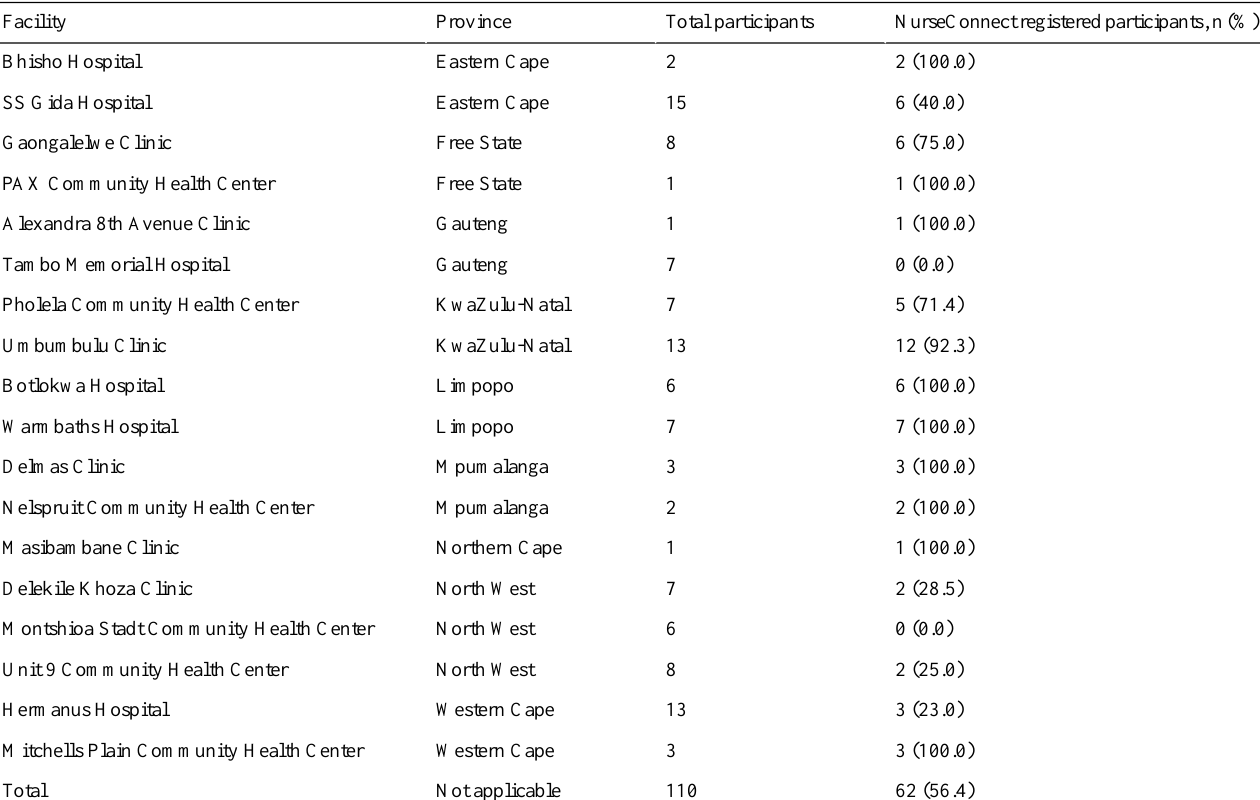
Table 1. Facilities sampled and the number of participants per